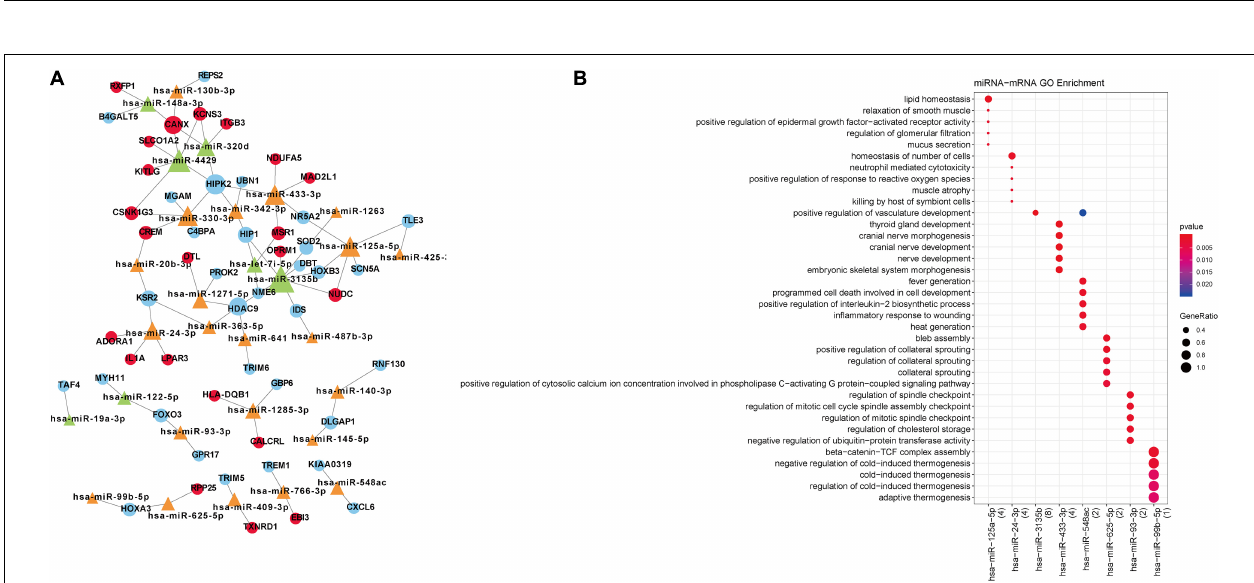
FIGURE 4 | (A) Differentially expressed miRNA-target network. Blue circular nodes are downregulated mRNAs; Red circular nodes are upregulated mRNAs; Green triangles are downregulated miRNAs; Orange triangles represent upregulated miRNAs. (B) The biological processes enriched by miRNAs. The changes in bubble color from blue to red indicate that the correlation is significant from low to high. Dot size GeneRatio is gene proportion. The size of the gene specific proportion indicates the proportion of the enrichment item.